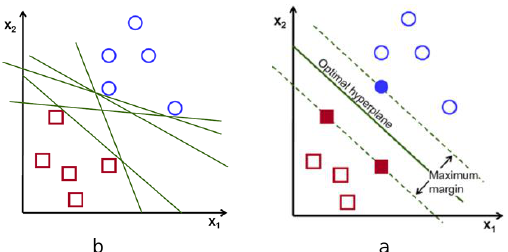
Fig 2. Meta Separator surface between two classes. A: Optimum separator surface. B: Meta Separator